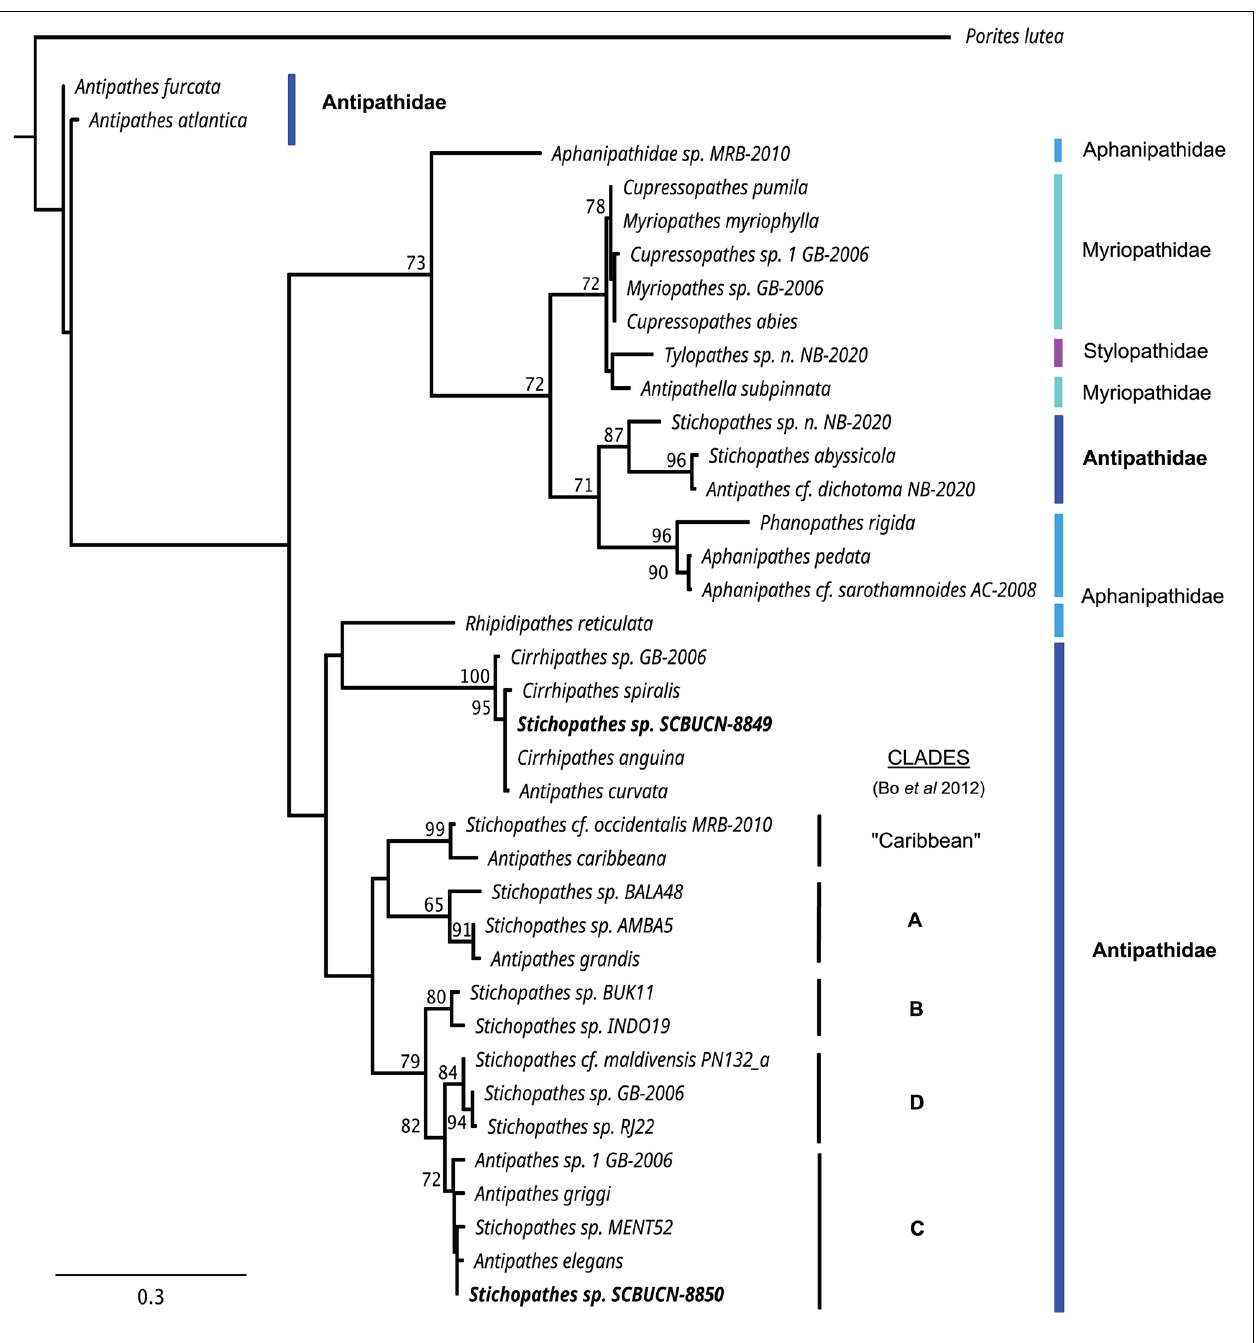
FIGURE 4 | Phylogenetic tree obtained by maximum-likelihood analysis based on internal transcribed spacer 1 rDNA (ITS1) of 37 antipatharian specimens of four families and the scleractinian coral Porites lutea as an outgroup. The two black coral specimens collected as part of this study are in bold. The numbers at nodes are the bootstrap estimated values ( > 65%). Antipathes-Stichopathes clades recognized in Bo et al. (2012) are indicated. See Supplementary Table 1 for GenBank accessions and localities of specimens.